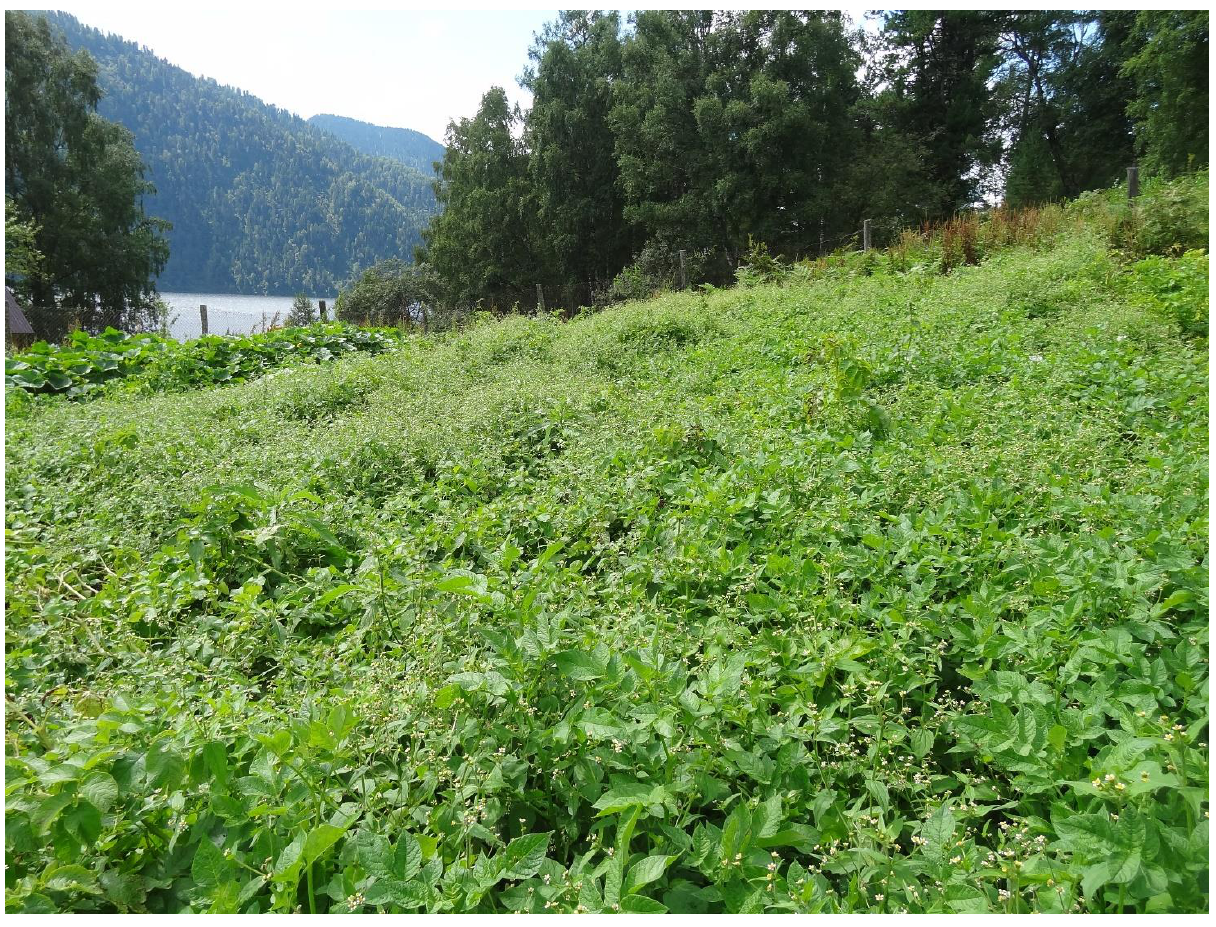
Fig. 4. Galinsoga ciliata near the Chelyush ranger station in the Altaiskiy Reserve. Most of the invasive and potentially invasive species of the reserve occur around houses. These are cultivated food and ornamental plants which easily leave places of cultivation: Armoracia rusticana, Impatiens glandulifera, Reynoutria sachalinensis, Xanthoxalis stricta (Fig. 5), as well as garden weeds: Galinsoga ciliata, Malva mohileviensis, Strophiostoma sparsiflorum. Other species are common on cattle yards, by the roadsides and on wasting lands: Lepidotheca suaveolens, Rumex crispus, Sonchus asper, Trifolium